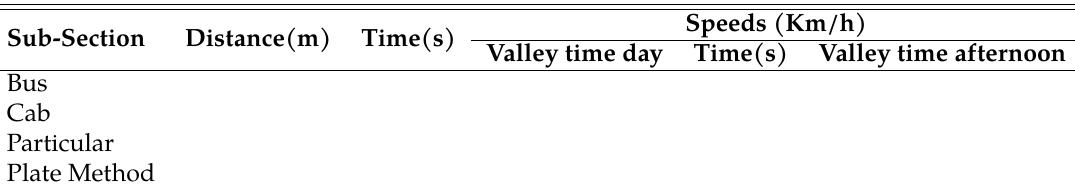
Table 1: Analysis of the means of transportation, in sections 1 and 2, in daytime off-peak time